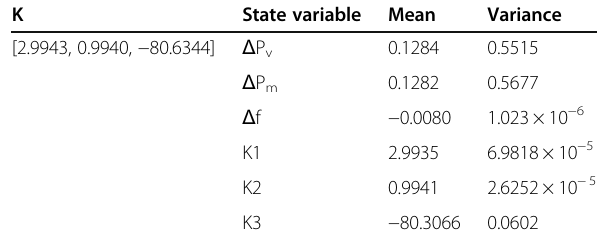
Table 5 Mean and variance of state variables estimated corresponding to a measurement noise variance of